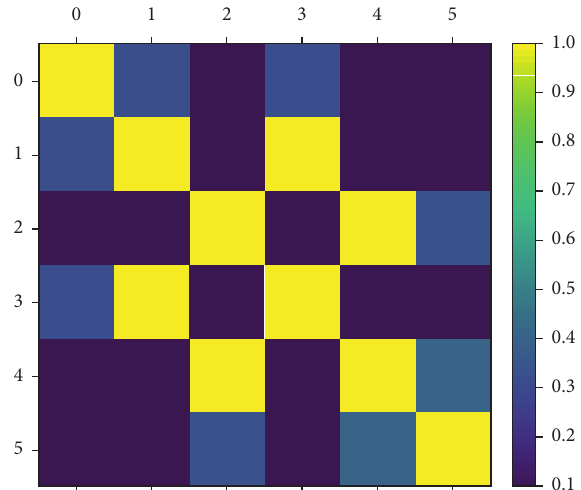
Figure 1: Thermal map of the correlation of indicators in the United